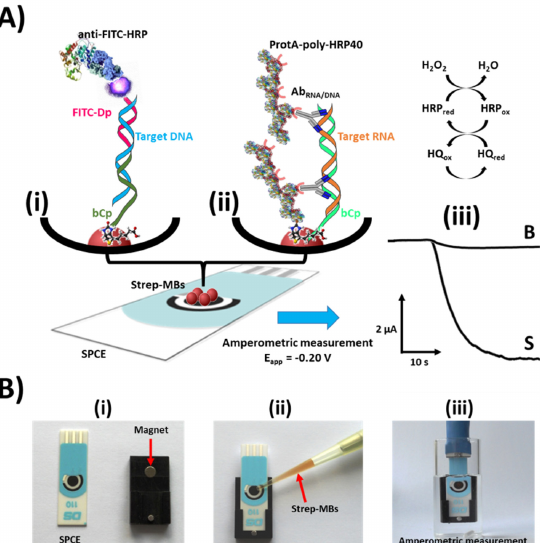
Figure 1. ( A ) Schematic diagram of the sandwich hybridization ( Ai ) with two probes (grey and red) and the heteroduplex hybridization ( Aii ) with one probe (green) immobilized on an electrode and concomitant redox reaction to generate the electrochemical signal (far right). Real amperometric traces obtained with the developed biosensors in the absence (Blank signal, B) and in the presence of a representative algae RNA (Signal, S) ( Aiii ). ( B ) Photographs showing the magnetic capture of the magnetic microbeads (MBs) on the working electrode of a screen-printed carbon electrode (SPCE) ( Bi , ii ) and the immersion of the SPCE / PMMA casing ensemble into the electrochemical cell where amperometric detections are carried out ( Biii